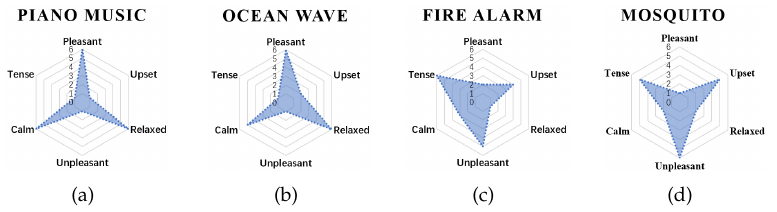
Figure 7. The subjective audio semantic questionnaire: the result of multiple perceptual evaluations on four different kinds of audio. ( a ) Piano music ( b ) Ocean wave ( c ) Fire alarm ( d )